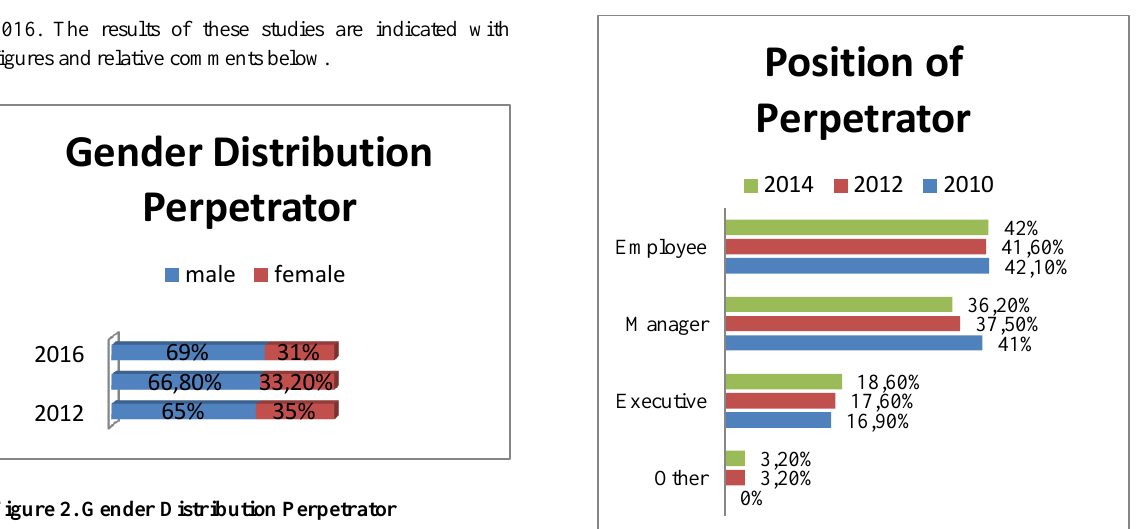
Figure 2. Gender Distribution Perpetrator Resource: ACFE, 2016